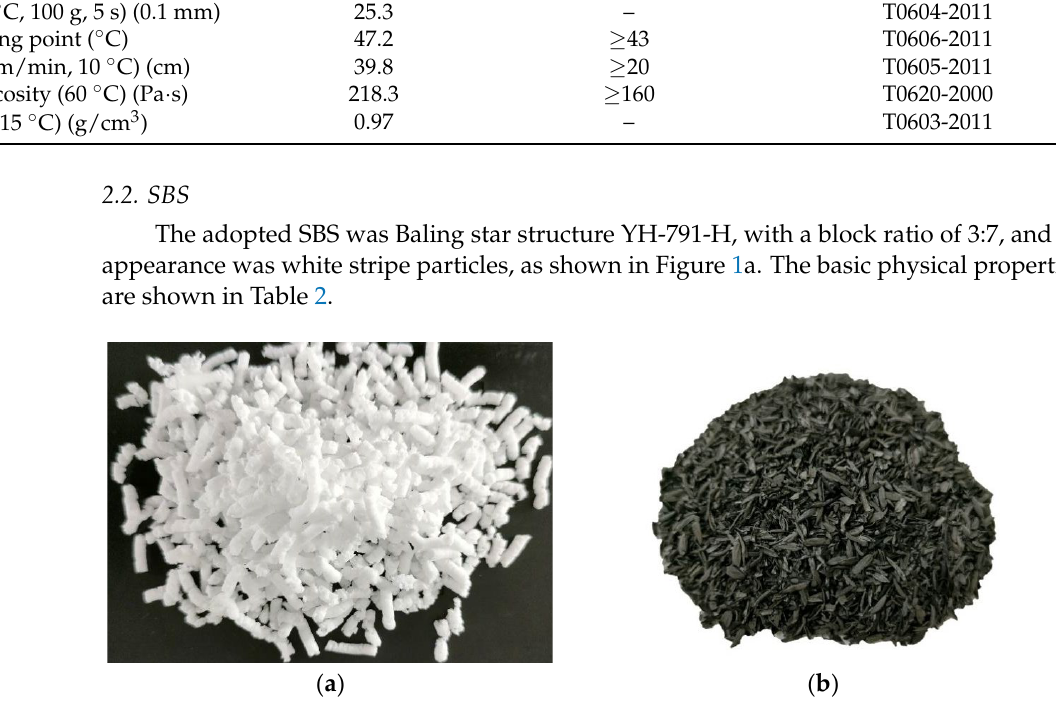
Figure 1. ( a ) Apparent morphology of SBS, ( b ) apparent morphology of rice husk biochar. Table 2. Basic physical properties of Table 3. Component analysis of rice husk biochar.